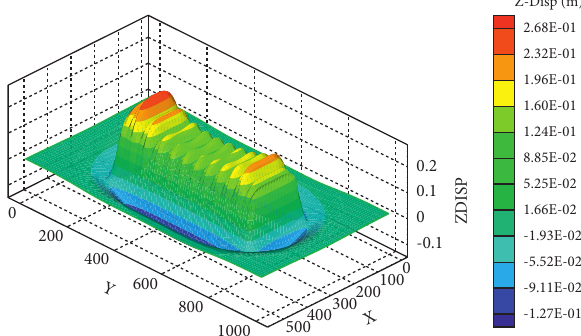
Figure 15: Simulation diagram of the displacement of the pro- tected roof.